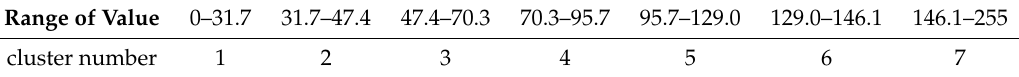
Table 4. Cluster number and the range of surface structure characteristic values.